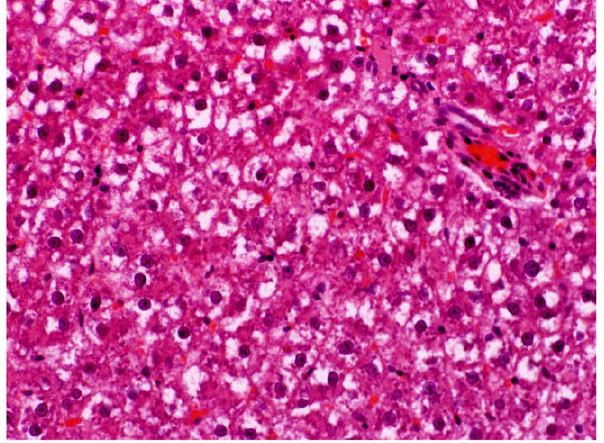
Figure 10. Liver injury group 2B. Parenchymal loss and haemor- rhage in liver from an animal in group 2B.